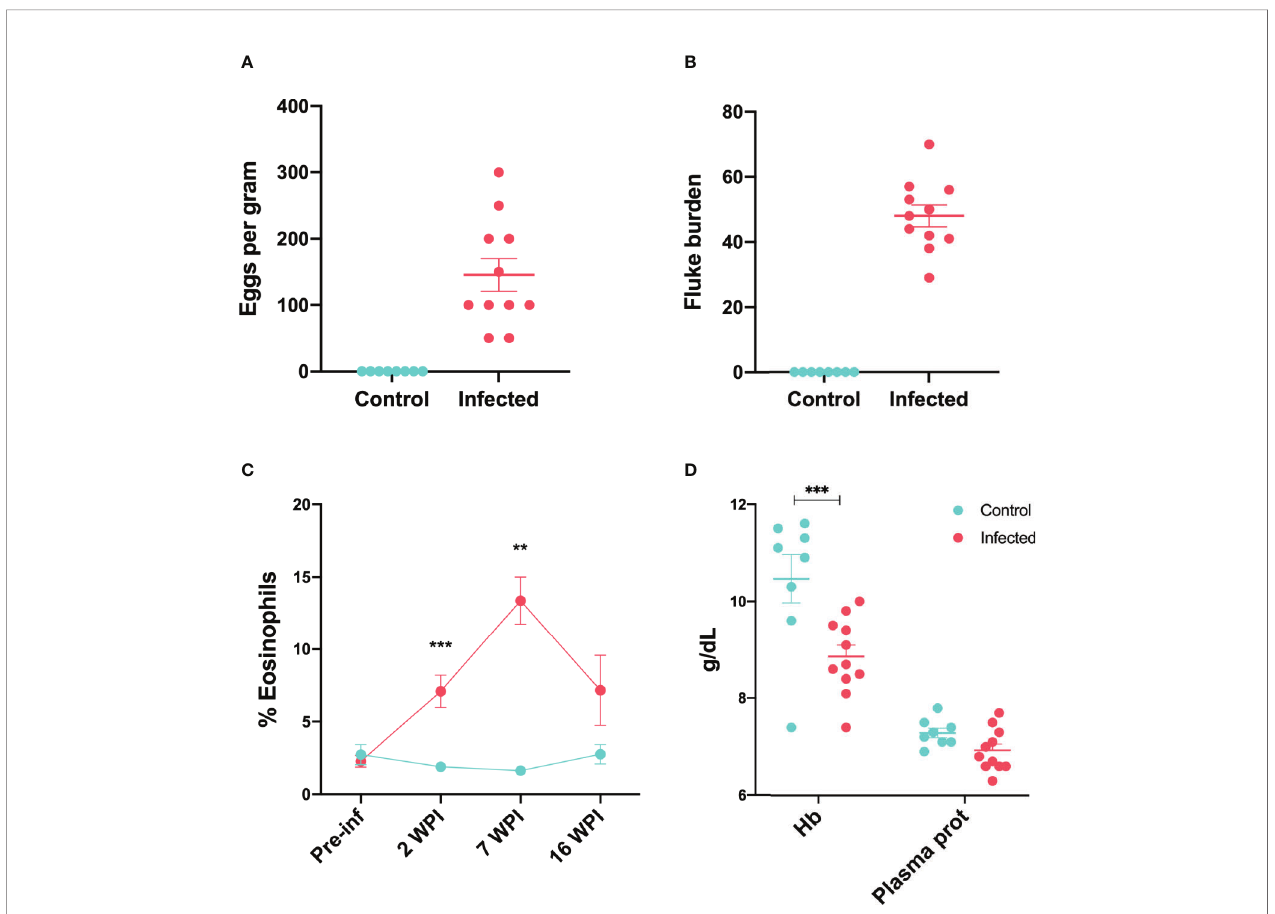
FIGURE 1 | Parasitological, haematological and serum biochemical changes in infected and control sheep (A) Faecal egg counts showed as eggs per gram at 15 wpi (B) Fluke burdens obtained at post-mortem 15 wpi. (C) Percentage of peripheral eosinophils in control and infected animals throughout the infection trial. Data from all 11 infected and 8 control animals is included in each time-point except for 7 wpi, where data from 7 infected and 4 control animals were available. (D) Concentration of haemoglobin and total plasma proteins at 16 wpi in control and infected animals. Bars represent mean and standard error of the mean. ** P < 0.01, ***P <